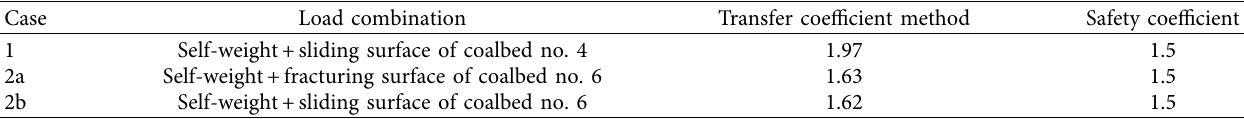
Table 11: Stability calculation results of the sectional sliding